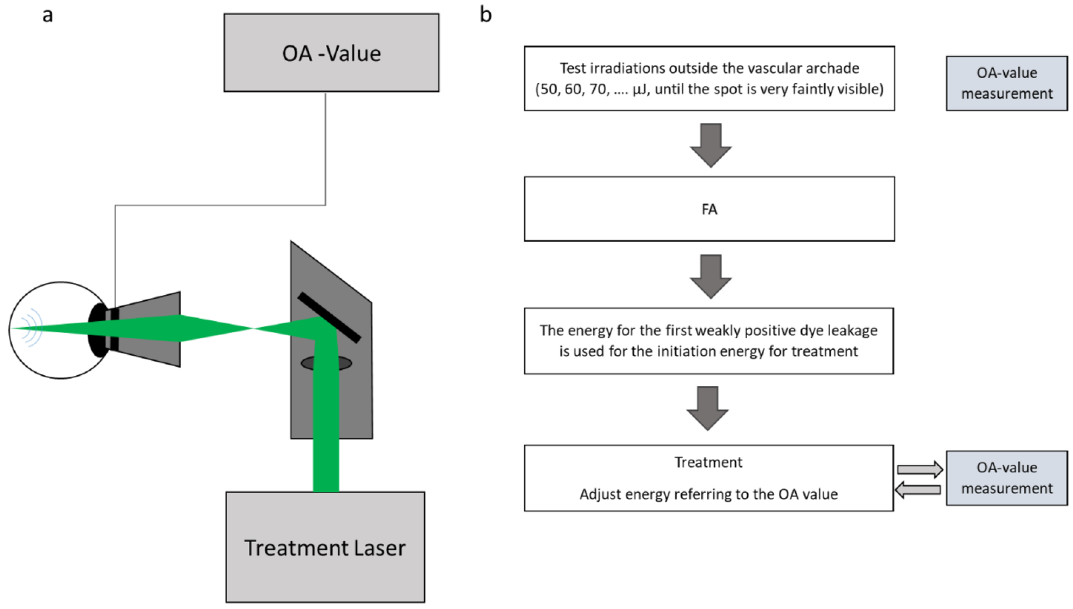
Figure 1. Schematic diagram of ( a ) the setup and ( b ) the treatment procedure of selective retina therapy